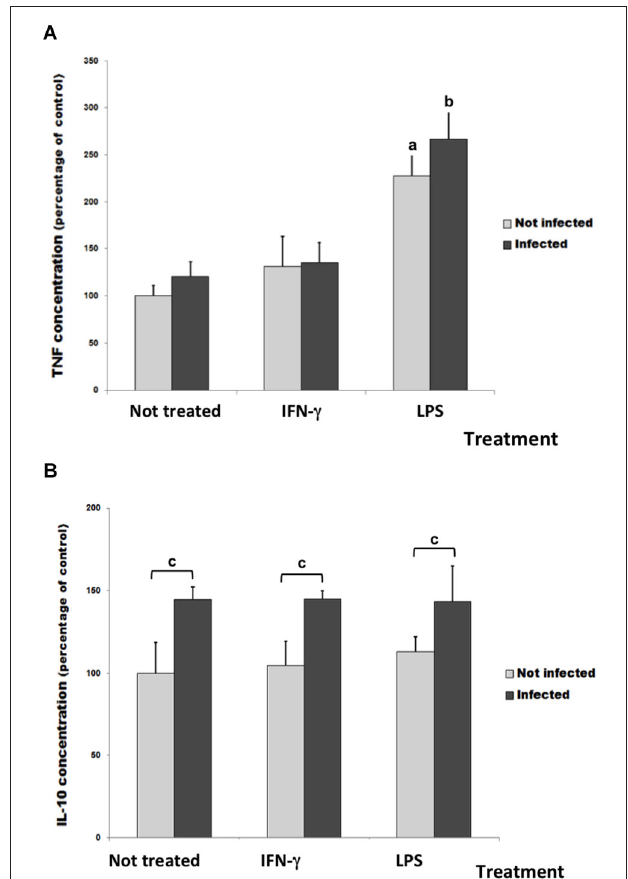
FIGURE 4 | TNF- α (A) and IL-10 levels (B) in culture medium of rat neuron/glial cell co-cultures treated with 300 IU/mL of IFN- γ or 1 mg/mL of LPS and infected with Neospora caninum tachyzoites (ratio cell:parasite 1:1), 72 h post infection . Data represent the percentage of concentration means and its respective standard deviation compared to untreated control cultures (considered as 100%) three independent experiments carried out in triplicates. “a” represents a significant statistical difference when compared to untreated/uninfected control cultures; “b” represents a significant statistical difference when compared to untreated/infected cultures; “c” represents a significant statistical difference between the same treatment group; (Two-way ANOVA/Tukey’s Multiple Comparison Test— p < 0.05).